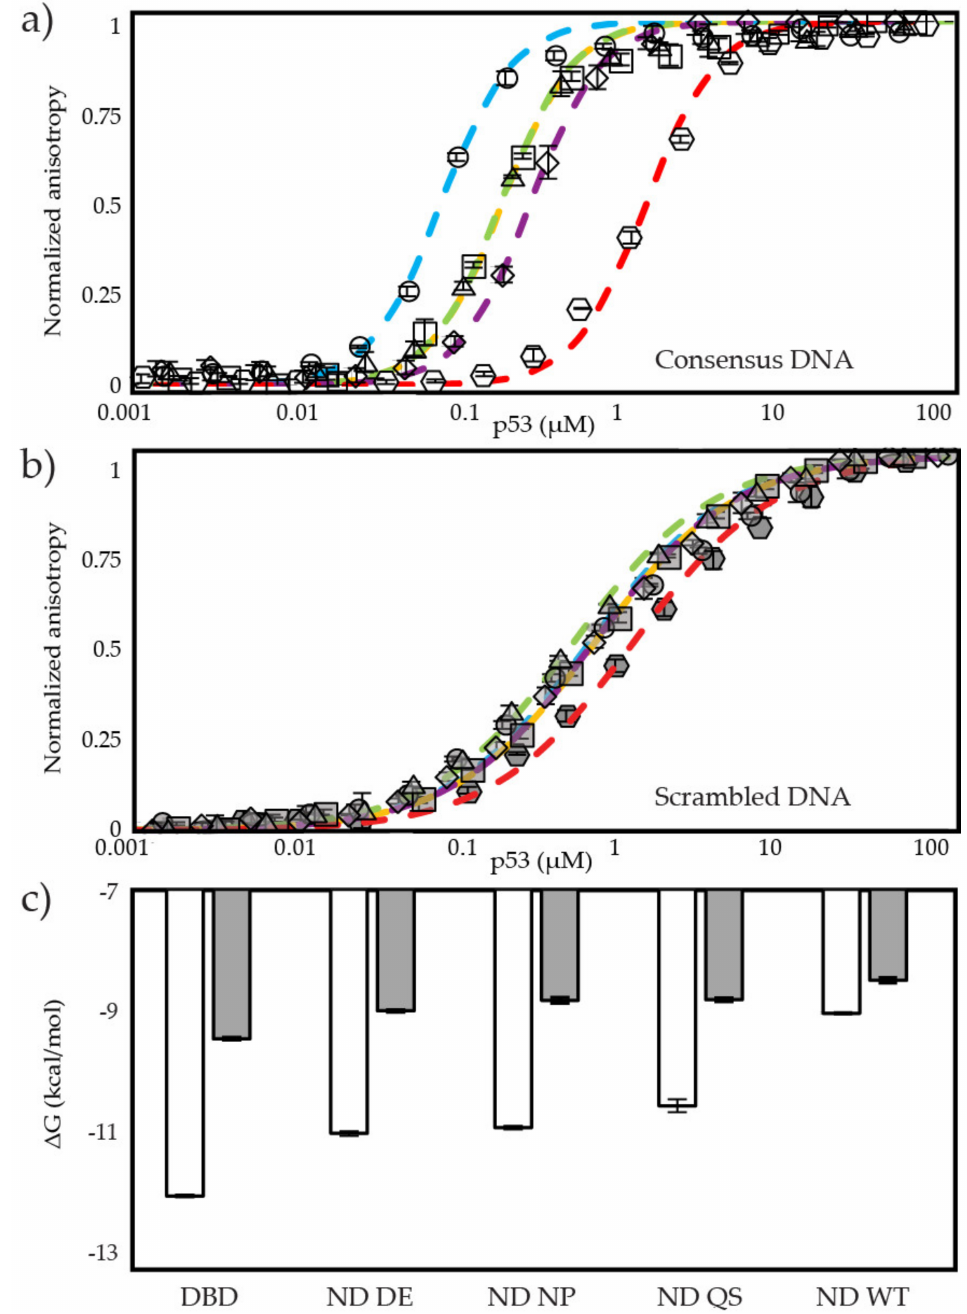
Figure 3. Binding of DBD and ND fragments to consensus and scrambled DNA at physiological IS (145 mM). ( a ) Fluorescence anisotropy plots of p53 constructs binding consensus DNA, where is DBD, is ND WT, is ND DE, is ND NP, is ND QS, ( b ) p53 constructs binding scrambled DNA, where is DBD, is ND WT, is ND DE, DNA, is ND NP, is ND QS, ( c ) ∆ G of all fragments with consensus and scrambled DNA. Each data set represents three